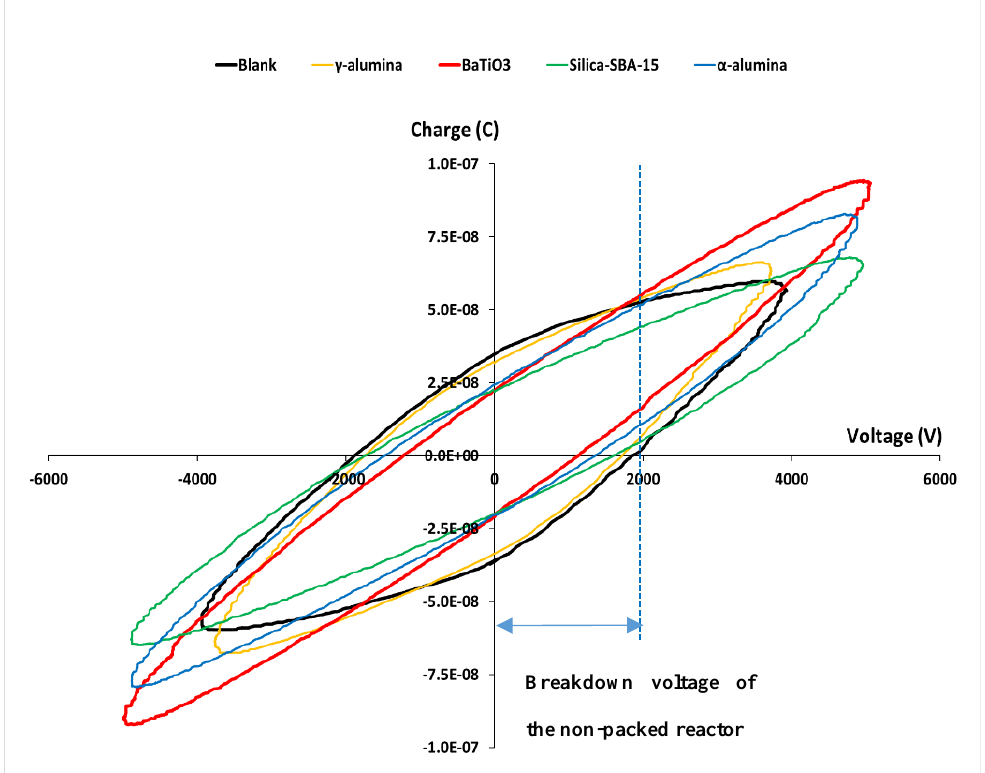
Figure 1. Lissajous figures for different packing materials packed inside the dielectric barrier discharge (DBD) plasma reactor.